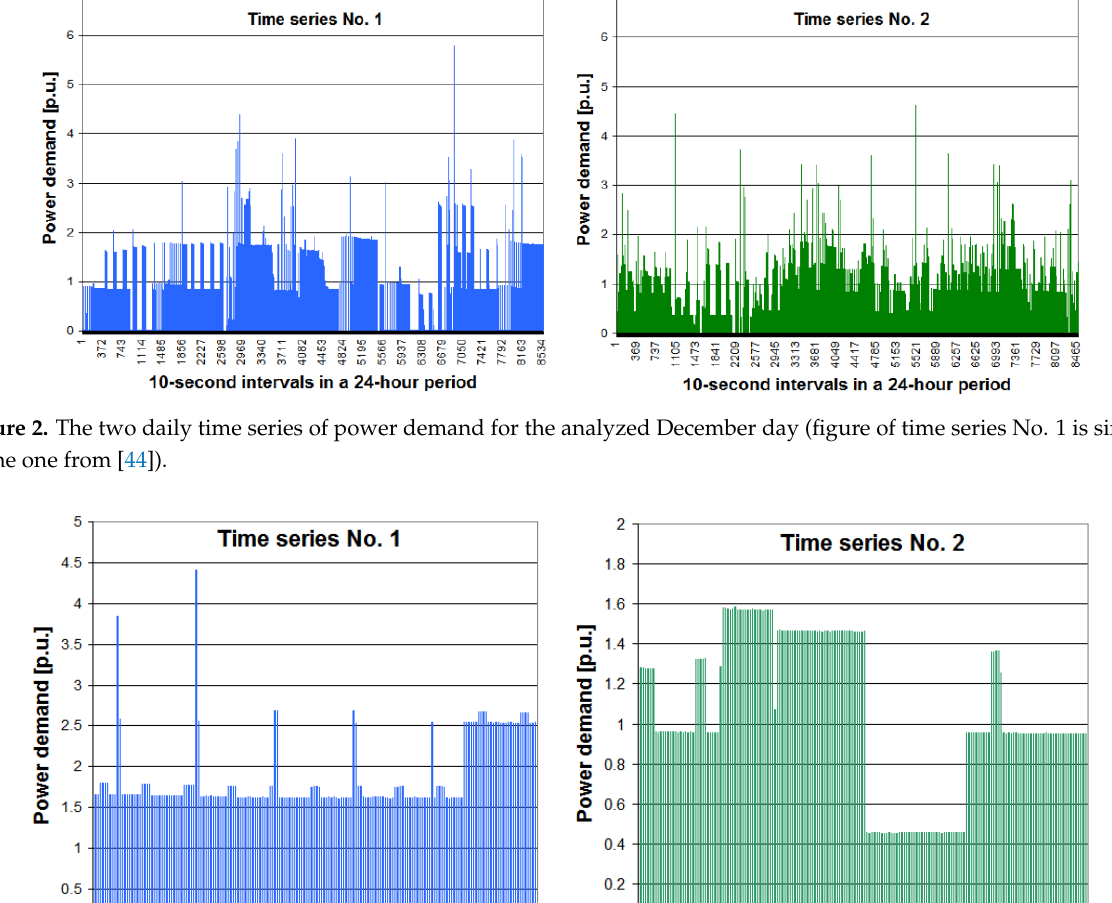
Figure 1. Percentage distribution of cases in both time series depending on the power demand value.